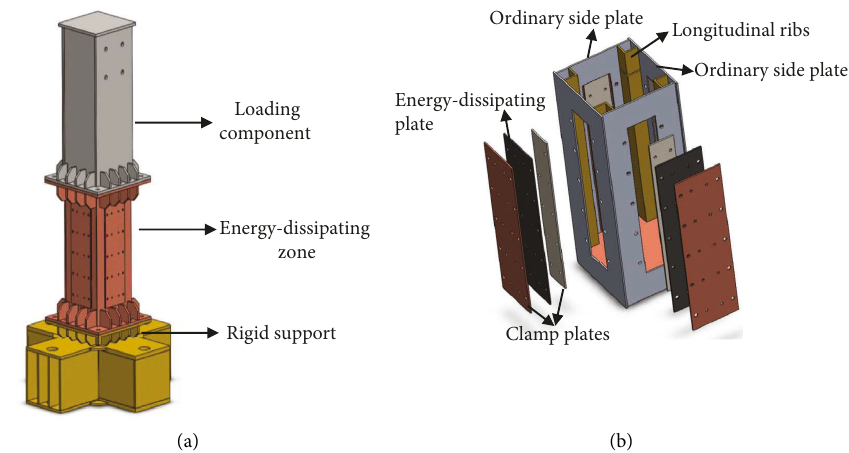
Figure 1: New type of box-shaped steel pier. (a) Three-dimensional diagram. (b) Energy-dissipating zone.